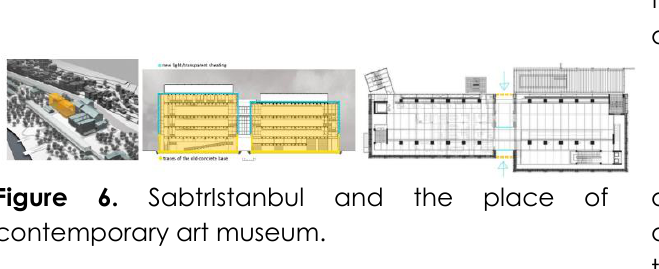
of the original 1910 plan referees the compacts and the necessity for unifying the complex in order to increase the energy efficiency of the